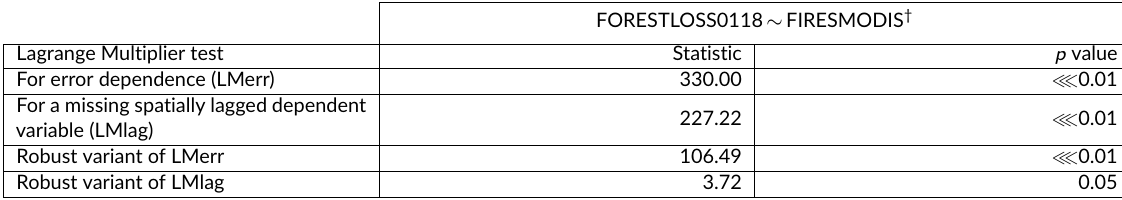
Table S2 – Lagrange Multiplier tests for spatial dependence in linear regression models of forest loss as a function of fire density for the period 2001-2018 (MODIS fire